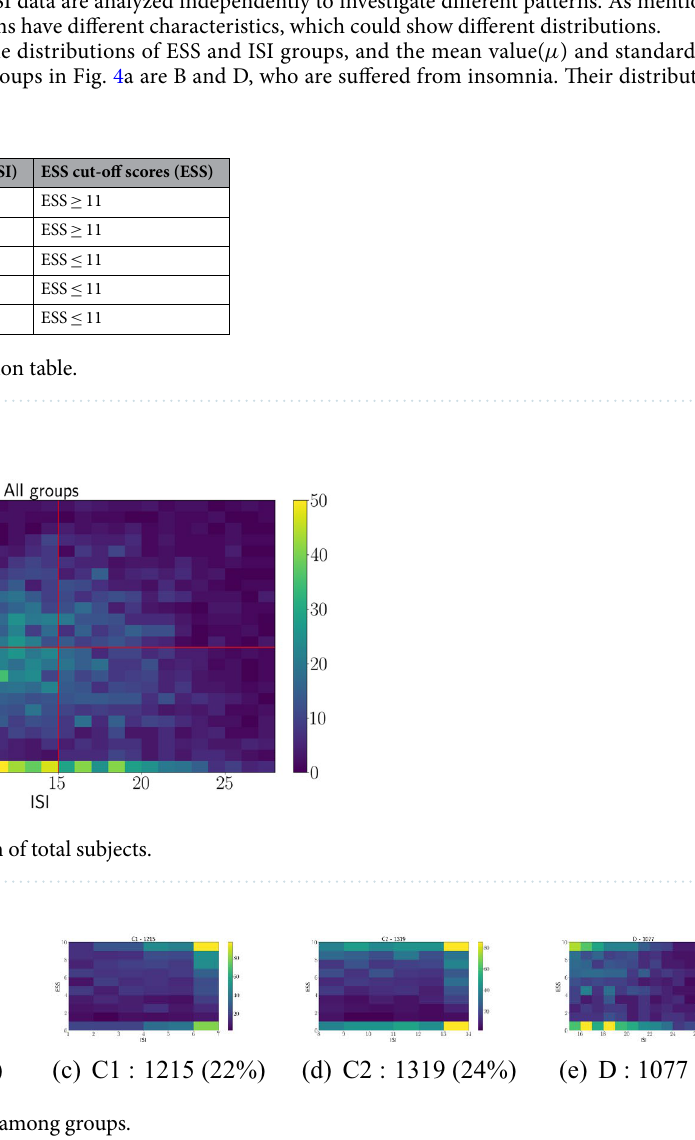
Figure 2. Histograms for among